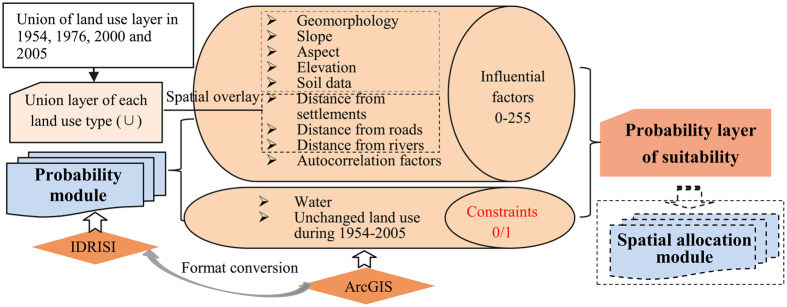
Probability module.